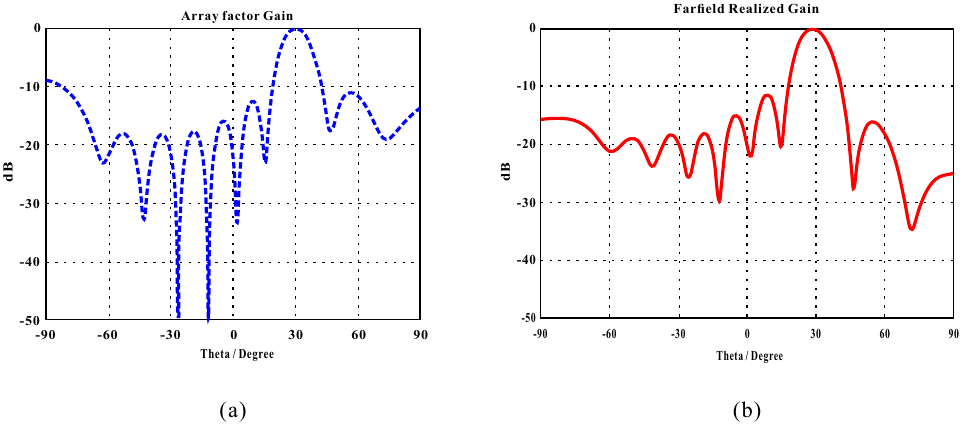
Figure 8. Comparison of 8 × 8 random grid array uniform feeding 2D radiation patterns: ( a ) array factor of conformal array calculated using MATLAB and ( b ) radiation pattern from EM